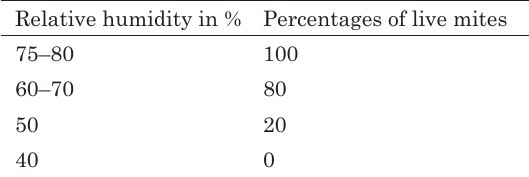
table 2. relative humidity and mite survival relative humidity in % Percentages of live